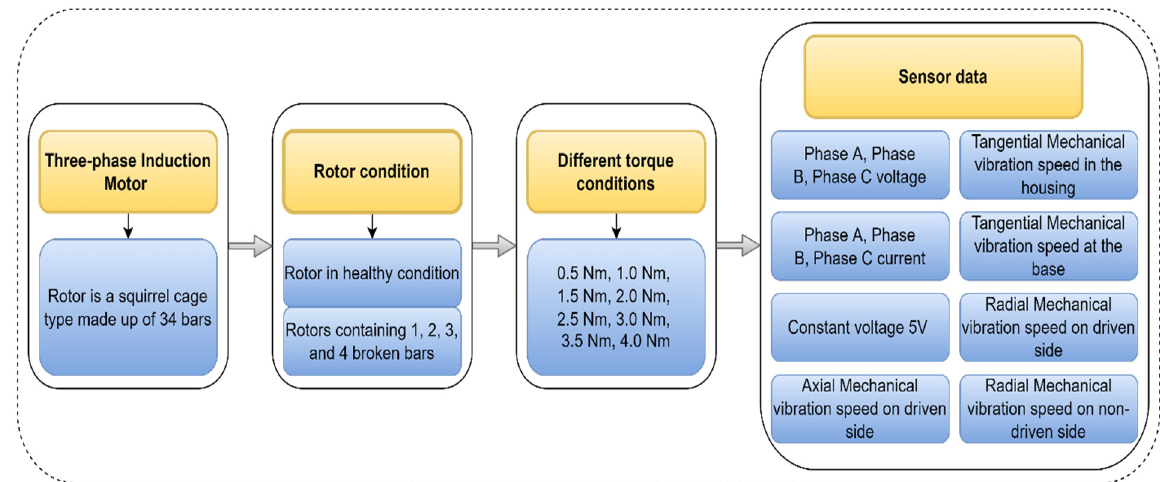
Figure 2. Dataset description of rotor broken bar in a three-phase induction motor.